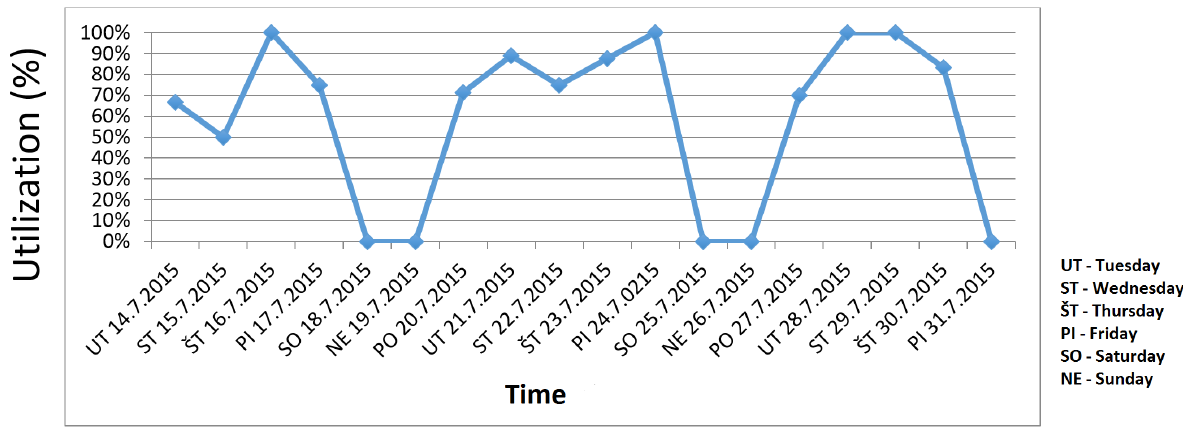
Figure 11: Utilization of AGV train rides.